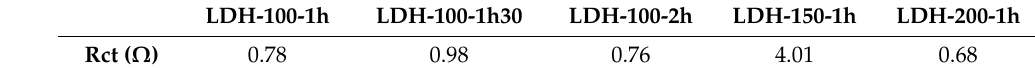
Table 4. Rct values for all the electrodes.